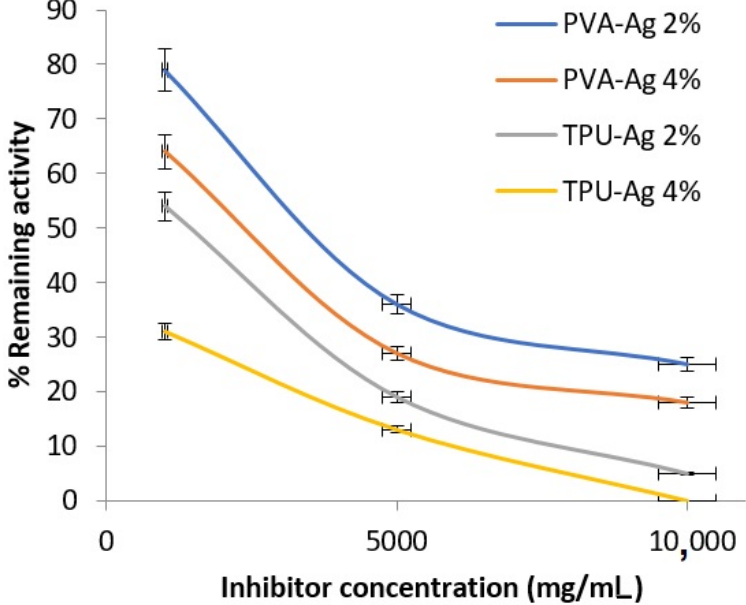
Figure 4. Percentage of remaining activity of HIV-1 Protease in presence of the tested nanofibers. On the other hand, in order to evaluate the antiCOVID-19 effect of manufactured PVA-Ag and TPU-Ag, a SARS-CoV-2 Inhibitor Screening Kit was used. Data in Figure 5 confirmed the effectiveness of the proposed nanofibers in deactivation of the spike protein of SARS-Cov-2. It was revealed that Ag concentration is the most effective factor in the antiviral activity. TPU was found to be more effective than PVA in Ag loading and the corresponding